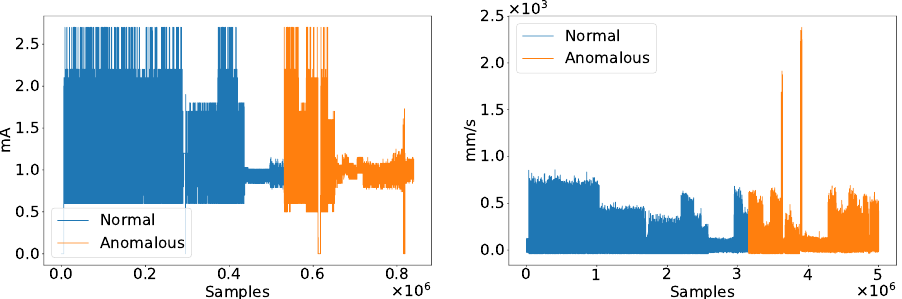
Figure 4. Current ( left ) and vibration ( right ) raw signals collected from the industrial plant in correspondence of the normal and anomalous